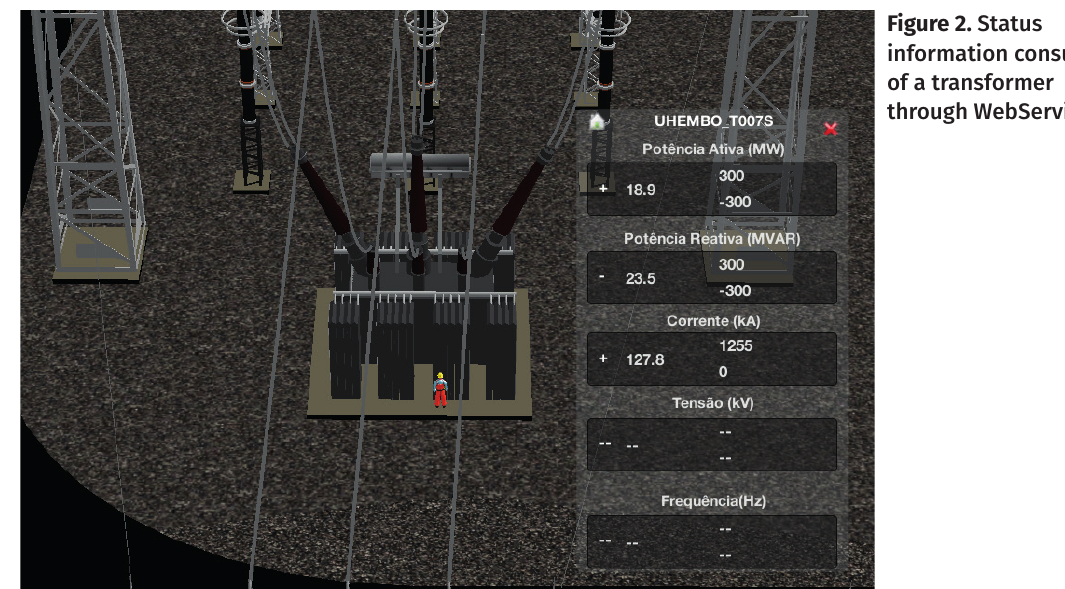
information consult of a transformer through